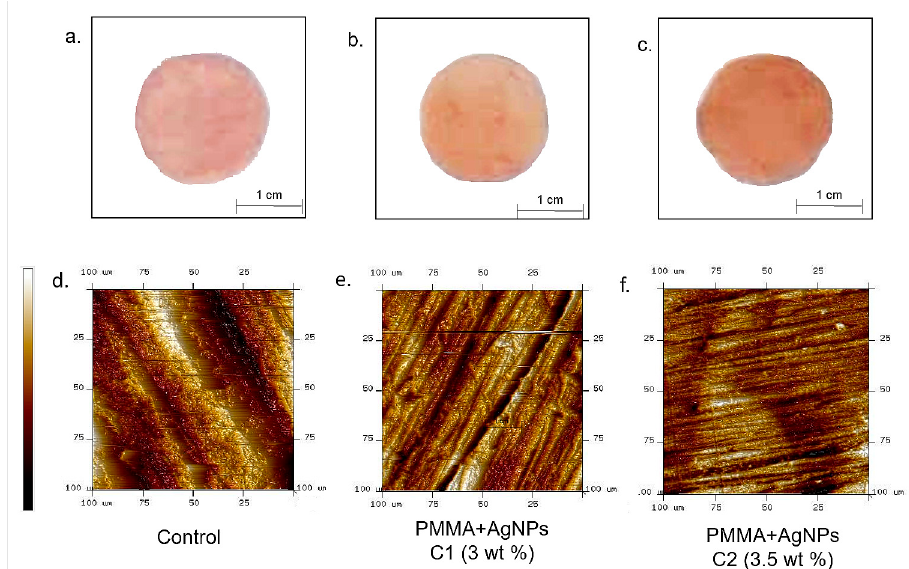
Figure 2. Images acquired by camera of poly(methyl methacrylate) (PMMA) without NPs added (control) ( a ); PMMA + AgNPs C1 (3 wt%) ( b ) and PMMA + AgNPs C2 (3.5 wt%) ( c ): The color became darker with increasing concentrations of the NPs. AFM topographical acquisitions of PMMA without NPs added (control) ( d ); PMMA + AgNPs C1 (3 wt%) ( e ) and PMMA + AgNPs C2 (3.5 wt%) ( f ).